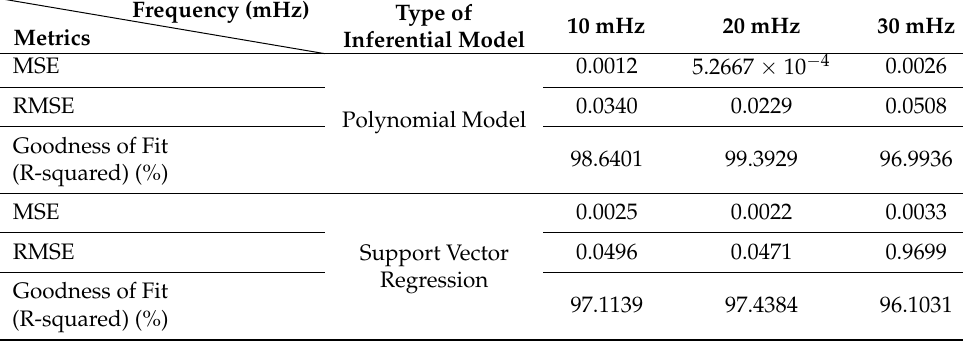
Table 6. Metrics of inferential models at different frequencies.